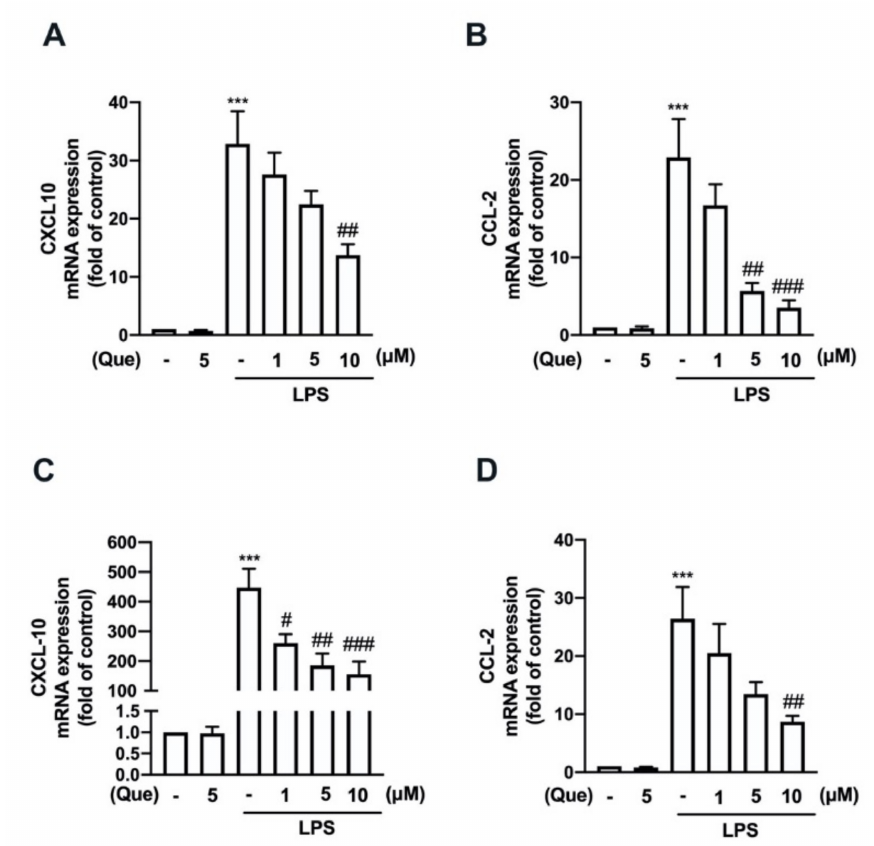
Figure 5. Inhibitory effects of quercetin on the expression of inflammatory mediators in macrophages and microglial cells. RAW264.7 ( A , B ) and IMG ( C , D ) cells were stimulated with various concentra- tions of quercetin (1, 5, or 10 µ M) for 30 min followed by stimulation with LPS (50 ng/mL) for another 6 h. mRNA levels of C-X-C motif chemokine ligand (CXCL)-10 ( A , C ) and C–C motif chemokine ligand (CCL)-2 ( B , D ) were analyzed by real-time PCR and normalized to β -actin. Each bar represents the mean ± SEM ( n = 3). Note: *** p < 0.005 compared with the control group. ### p < 0.005, ## p < 0.01, # p < 0.05 compared with the LPS alone